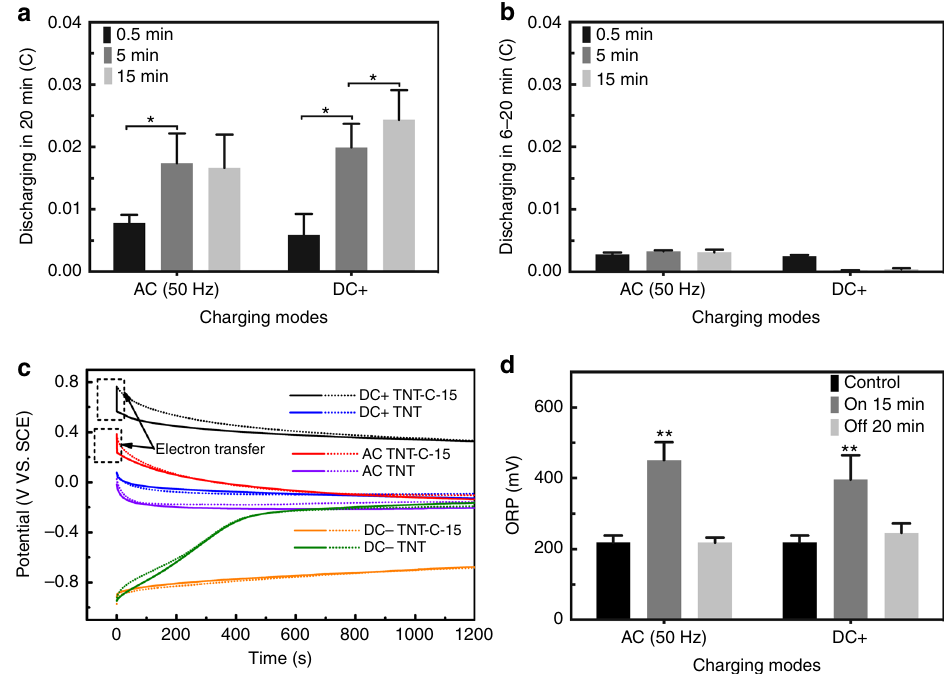
Fig. 6 Post-charging antibacterial mechanism analysis. a , b Total discharging capacity of TNT-C-15 in a 0 – 20 min and b 6 – 20 min after AC/DC + charging for 0.5, 5, and 15 min (*denotes P < 0.05, Student t test). c Potential curves of DC + charged TNT-C-15, DC + charged TNT, AC charged TNT-C-15, AC charged TNT, DC – charged TNT-C-15 and DC – charged TNT with solid/dashed lines denoting with/without bacteria, respectively. The pre-charging time is 15 min. d ORP in the LB medium during and after the charging process (**denotes P < 0.01 compared with the control group, Student t test). All error bars = s.d. ( n =